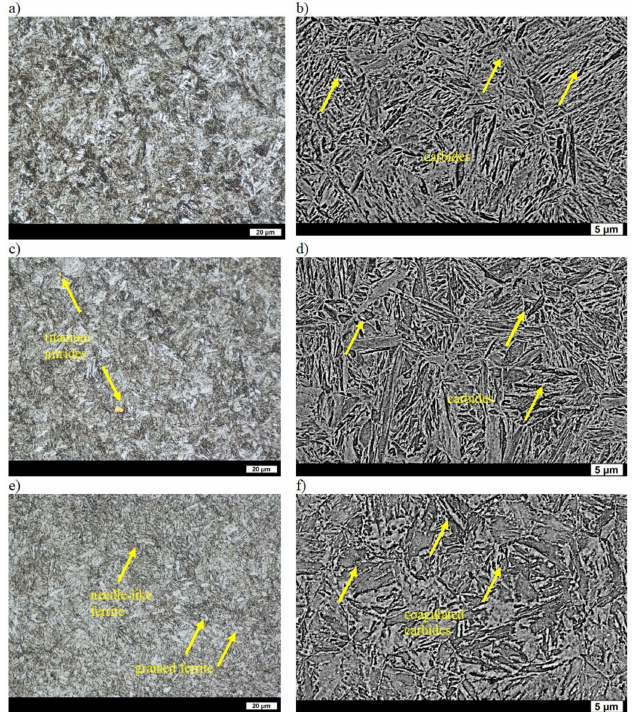
Figure 9. Microstructure of ingot No. 7 after quenching and tempering: ( a ) at 200 ◦ C, LM; ( b ) at 200 ◦ C, SEM; ( c ) at 400 ◦ C, LM; ( d ) at 400 ◦ C, SEM; ( e ) at 600 ◦ C, LM; ( f ) at 600 ◦ C, SEM. Etched with 3% HNO 3 .